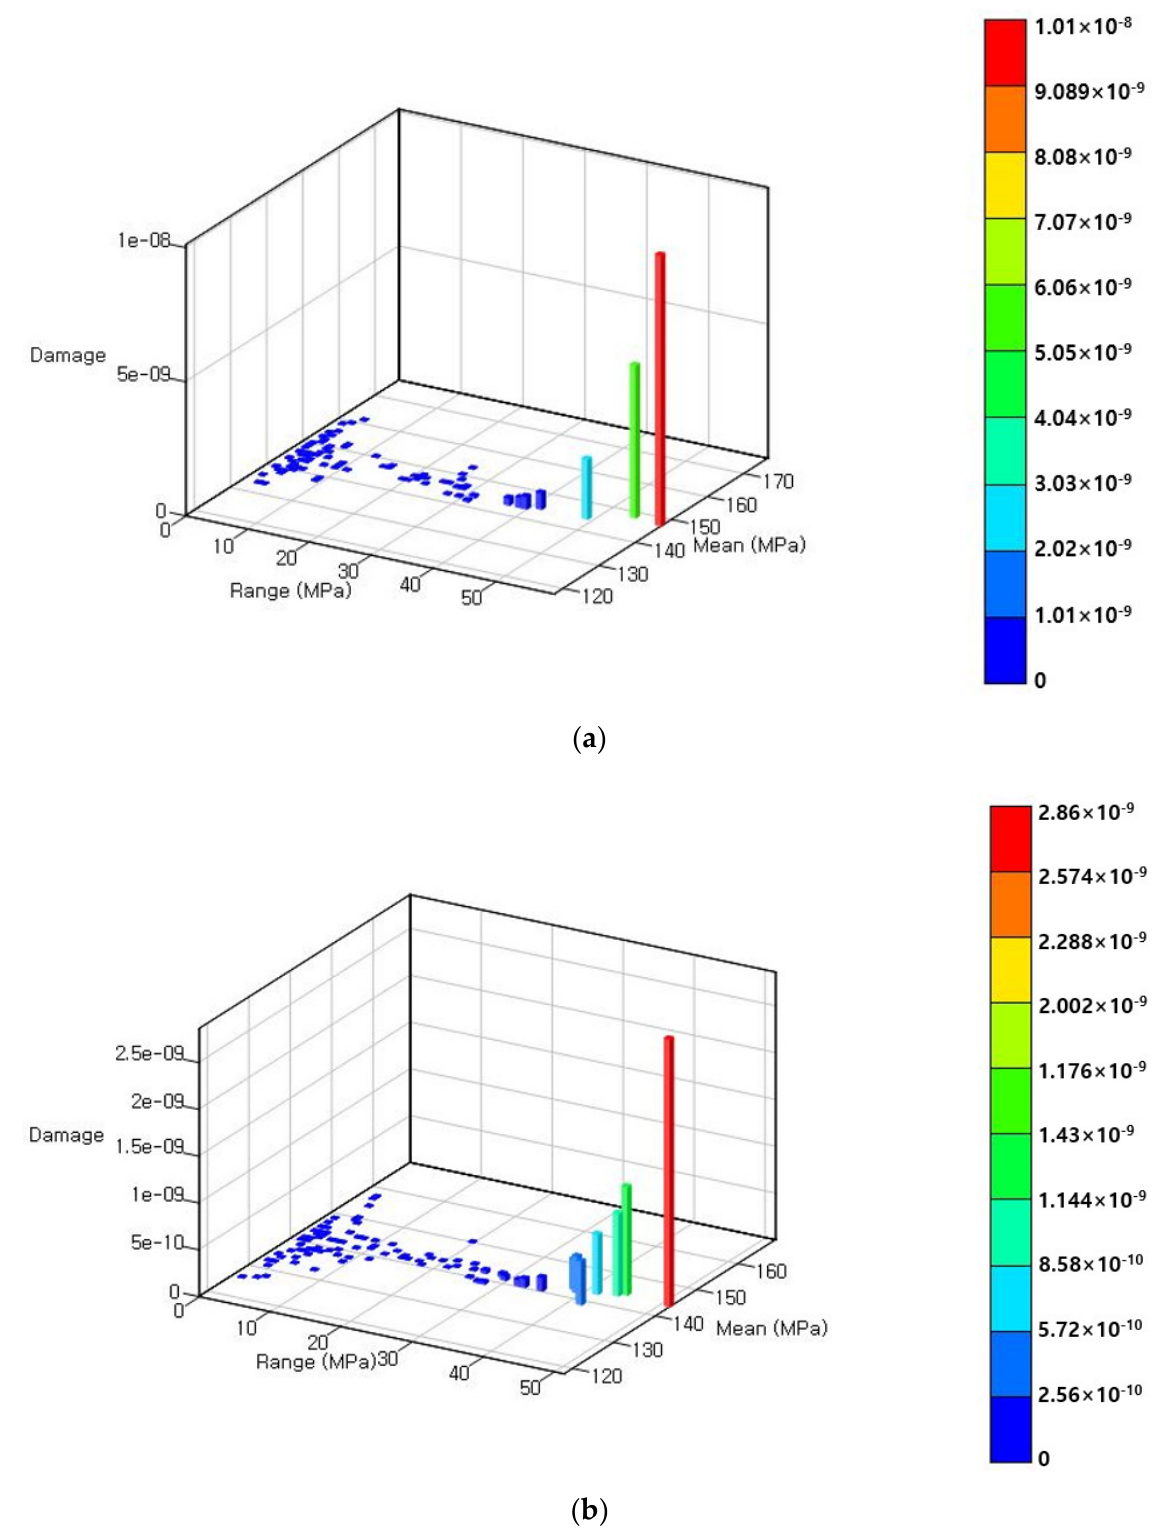
Figure 13. The shape of damage histogram when loading part is lifted: ( a ) fastening device 1; ( b ) fastening device 2.